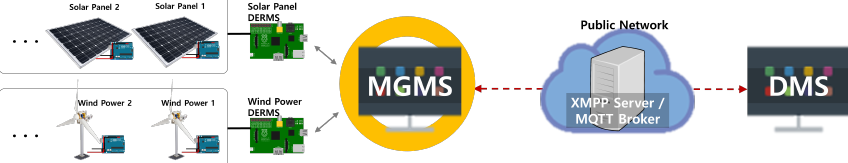
Figure 6. Microgrid system verification framework configuration diagram.